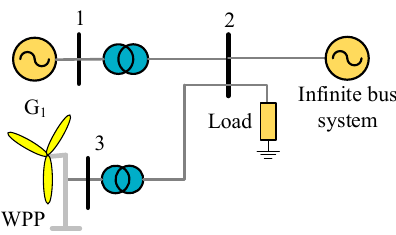
Figure 2. The stochastic single-machine infinite-bus (sSMIB). WPP: wind power plant; G 1 : Generator 1.